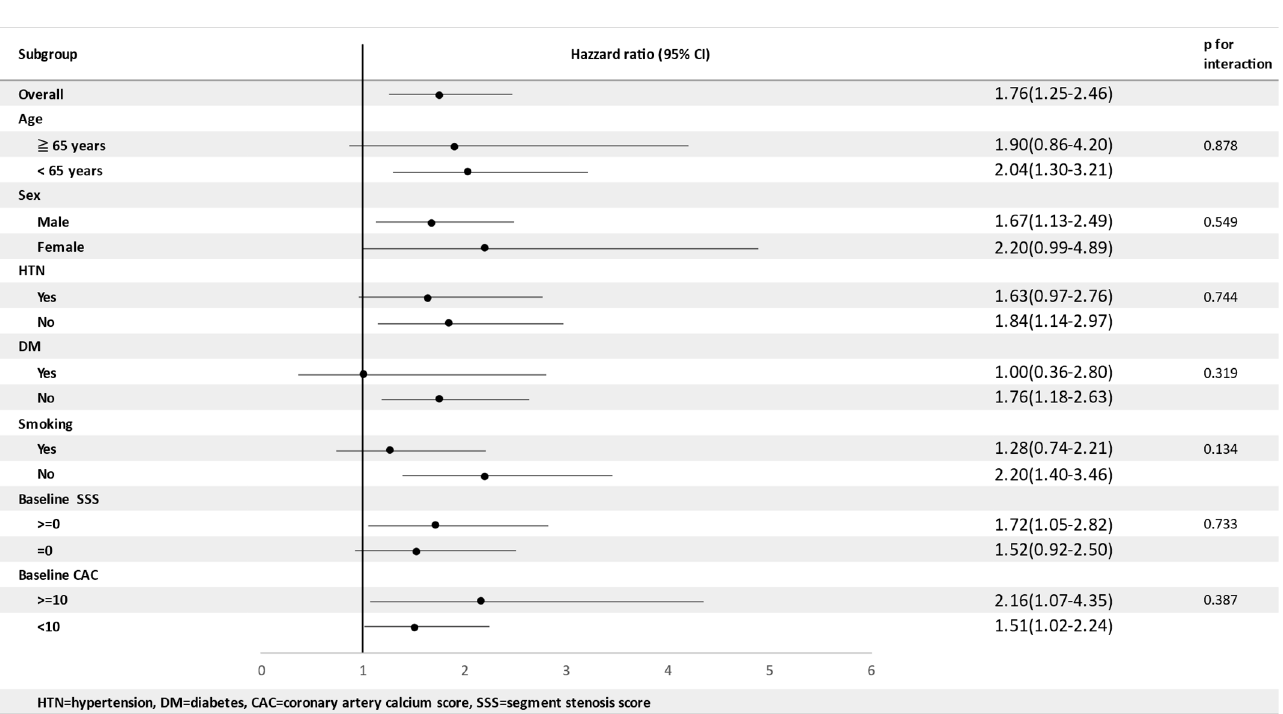
Figure 3. Interaction between NFS and the progression of atherosclerotic plaques in different subgroups